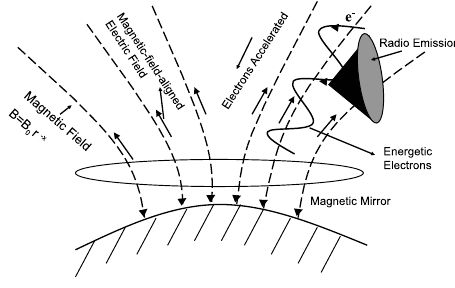
Figure 1. A model for coherent radio emission from ultracool